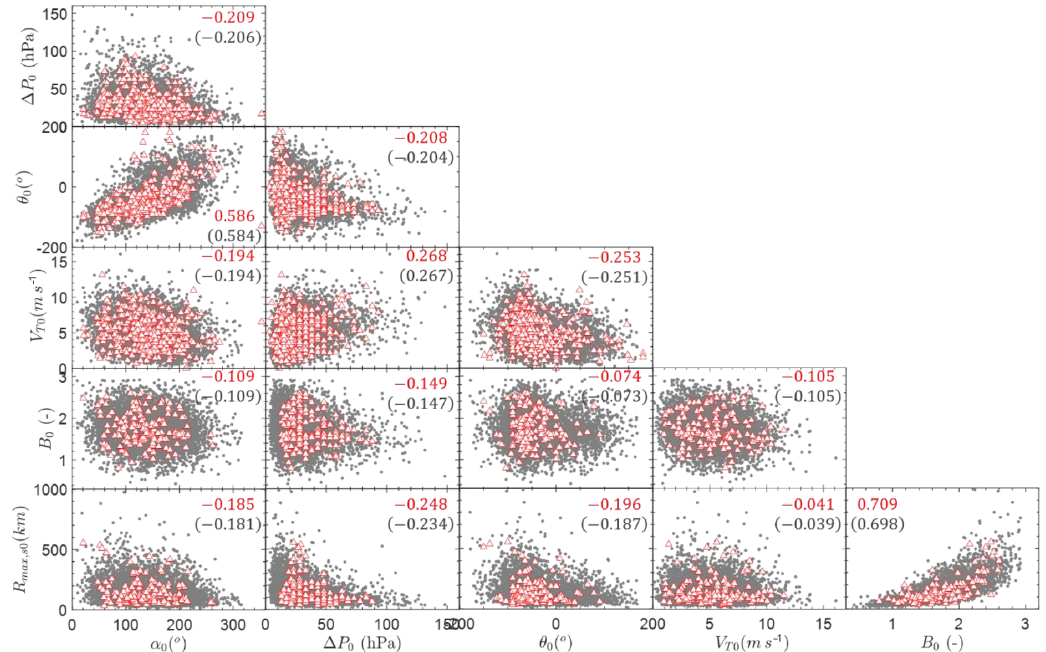
Figure 13. Simulated and observed genesis parameters (red triangles: observations; grey dots: simulations; upper numbers: ρ sim ; lower numbers in parentheses: ρ obs